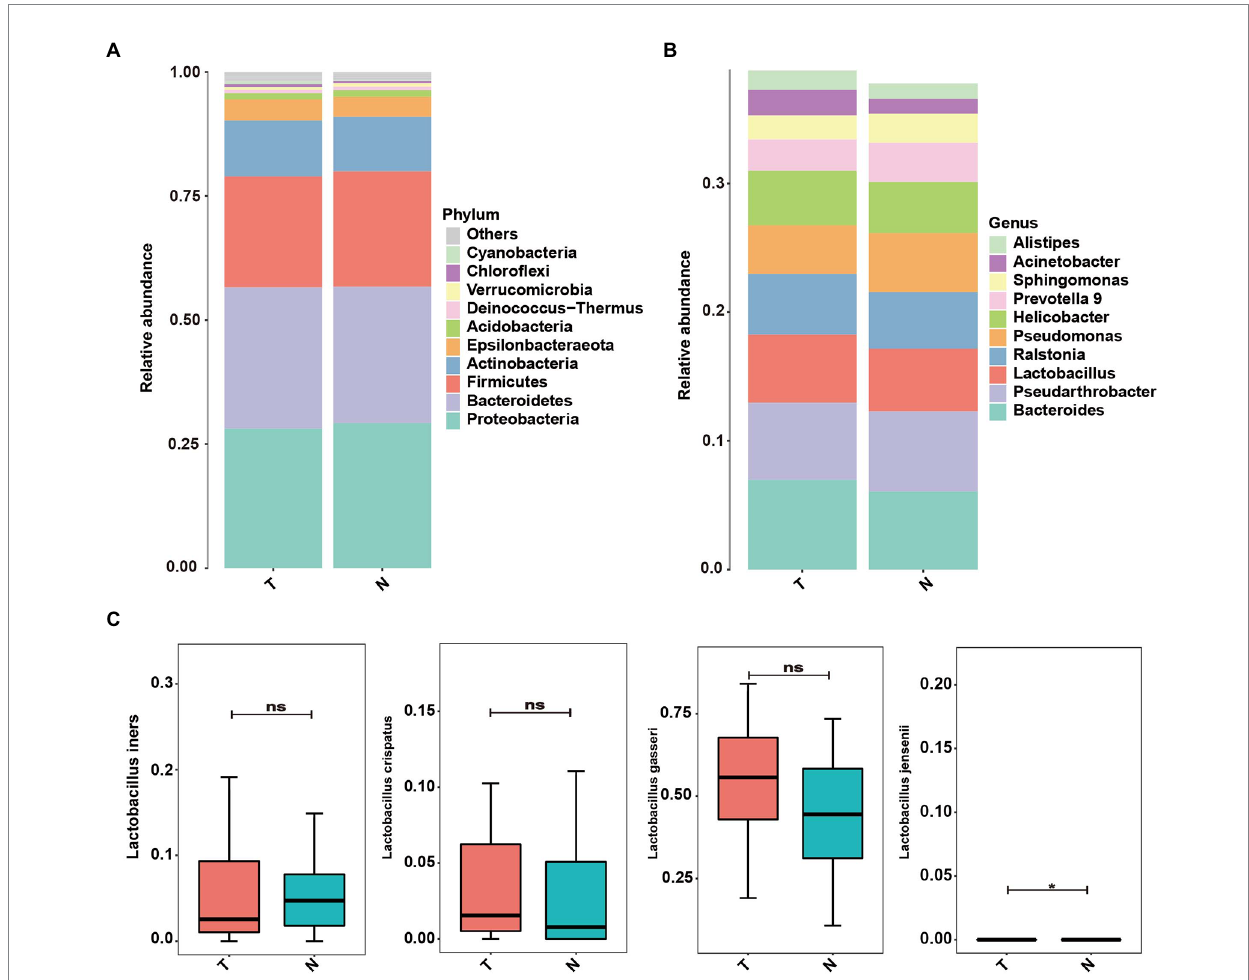
FIGURE 6 Abundance of microbes at different levels in the uterus of embryo-arrest and normal pregnancy groups. (A) Relative abundances of the vaginal microbiota at the phylum level. (B) Relative abundances of the vaginal microbiota at the genus level. (C) Relative abundance of Lactobacillus was reported with SEM as bar plots. T, embryo-arrest group; N, normal pregnancy group.